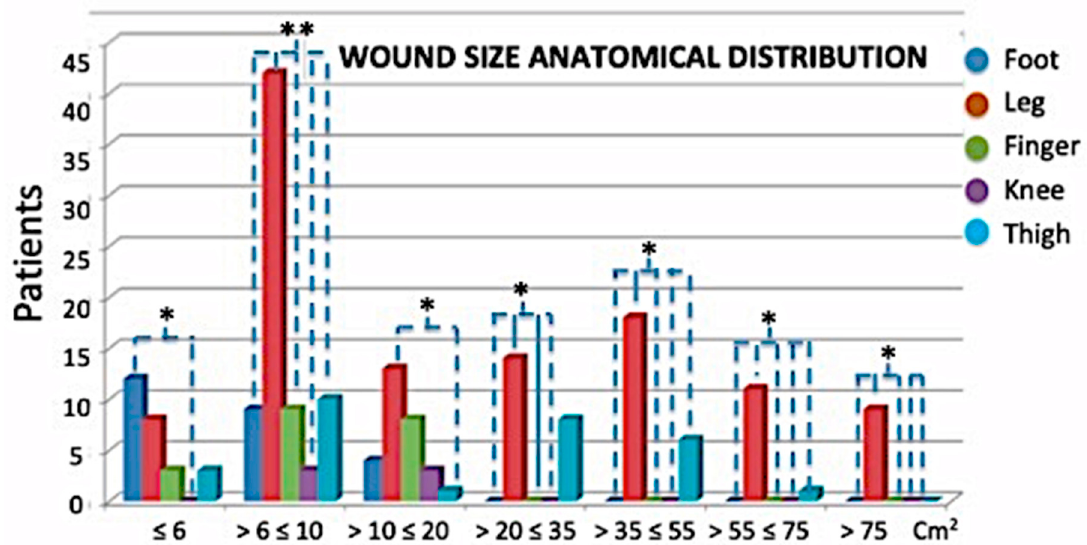
Figure 4. Anatomical sites (and sizes) of distribution Groups 1 and 2. The most frequent cases in both groups were chronic ulcers in the legs. Anatomical wound size distribution: 13.33% measured ≤ 6 cm 2 ; 37.44% measured > 6 ≤ 10 cm 2 ; 14.87% measured > 10 ≤ 20 cm 2 ; 11.28% measured > 20 ≤ 35 cm 2 ; 12.30% measured > 35 ≤ 55 cm 2 ; 6.15% measured > 55 ≤ 75 cm 2 and 4.62% measured > 75 cm 2 . * p < 0.05; ** p < 0.01.